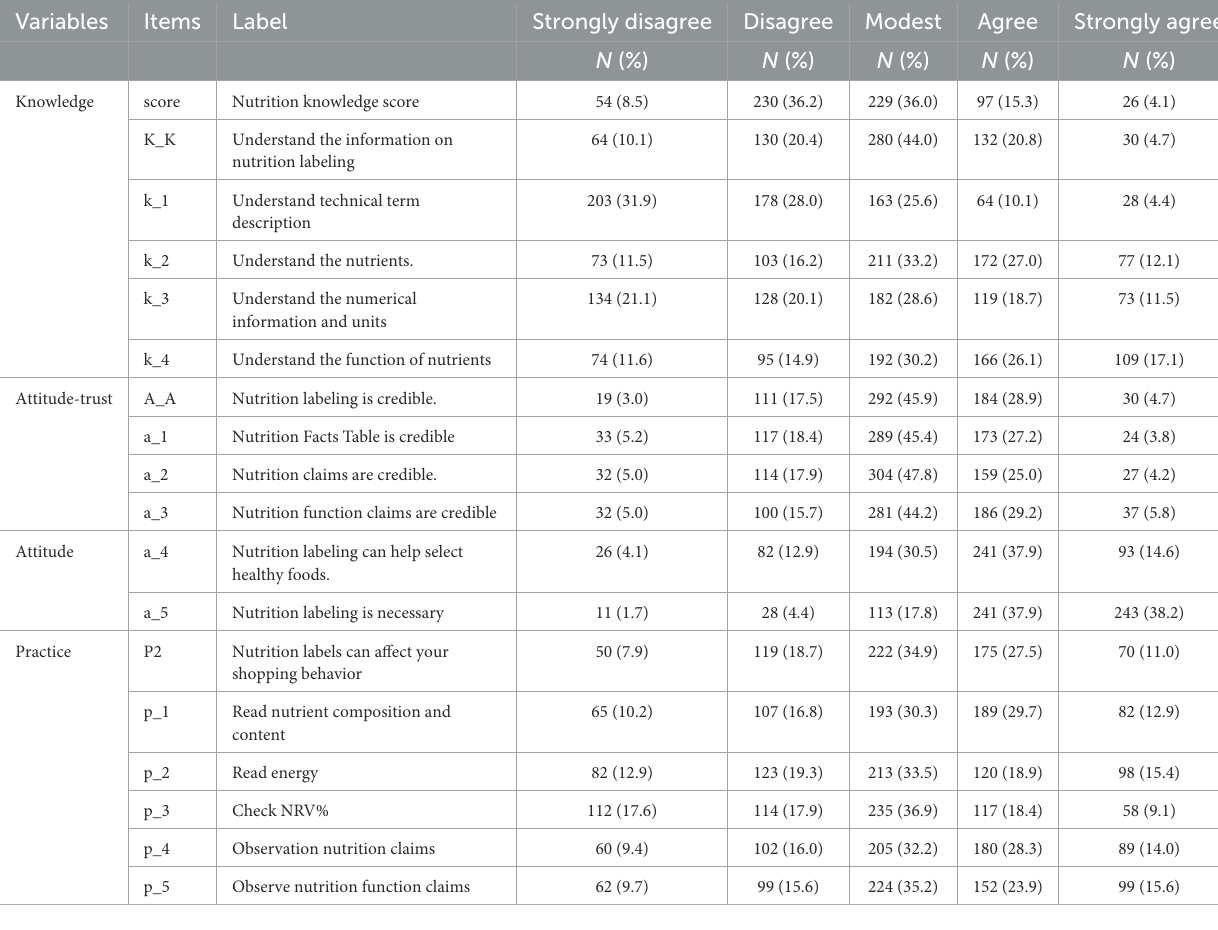
TABLE 4 Description of variables and summary statistics.